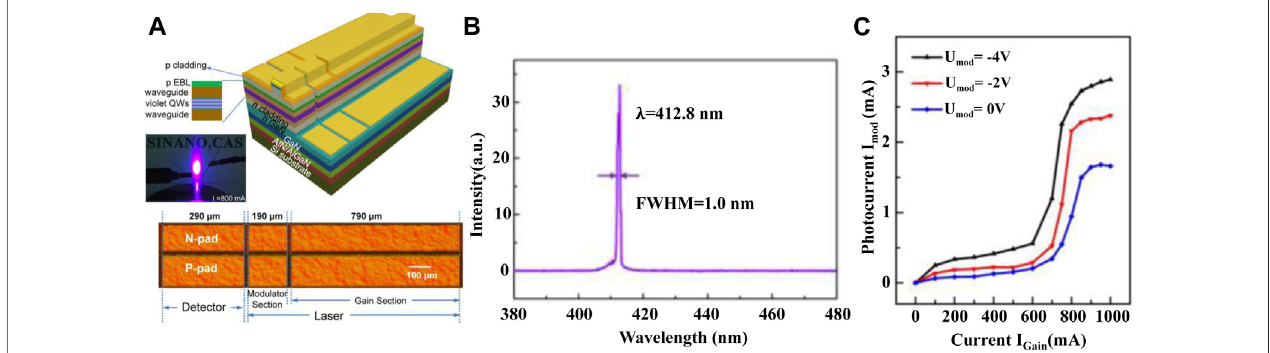
FIGURE 11 | (A) Schematic diagram of integrated devices; (B) lasing spectra of GaN LDs; (C) photocurrent response curves at different bias voltages (Feng et al., 2018). Reprinted with permission © IEEE Xplore Publishing (Feng et al.,